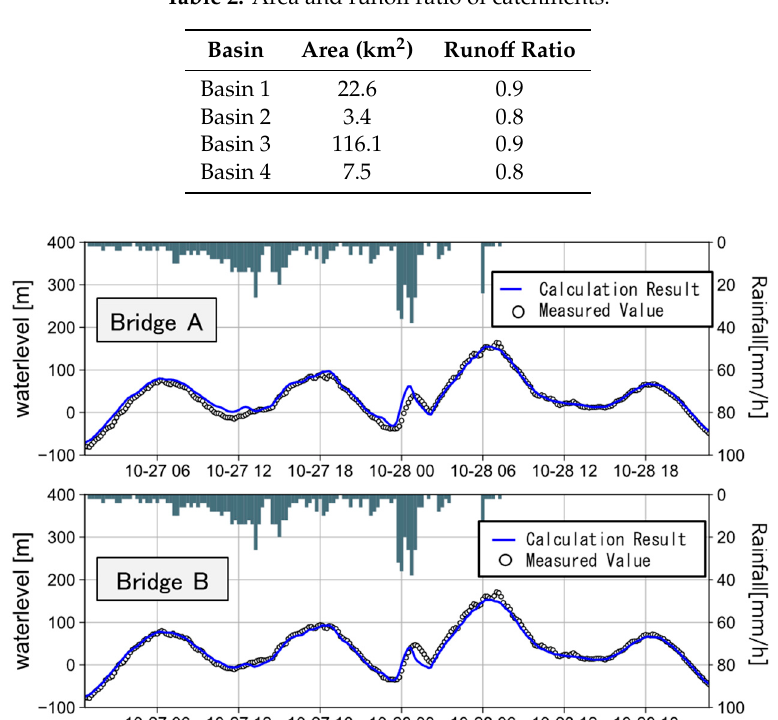
Table 2. Area and runo ff ratio of catchments.